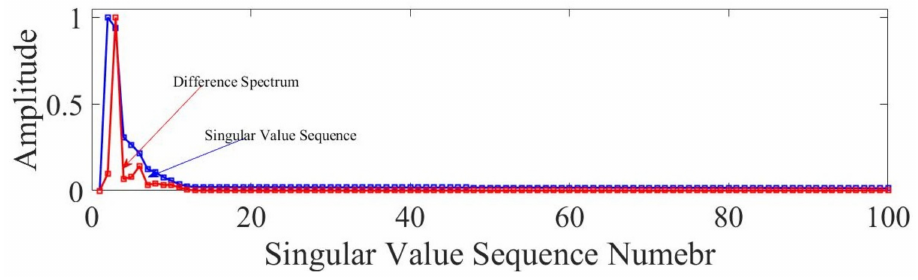
Figure 5. HSVD singular value sequence and its difference